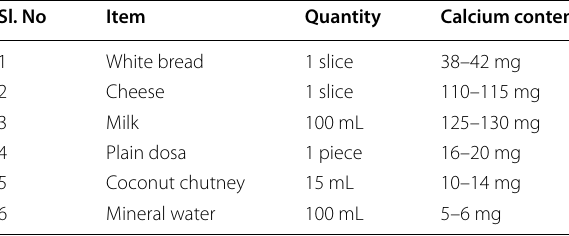
Table 3 Calcium content of some common food items Sl.